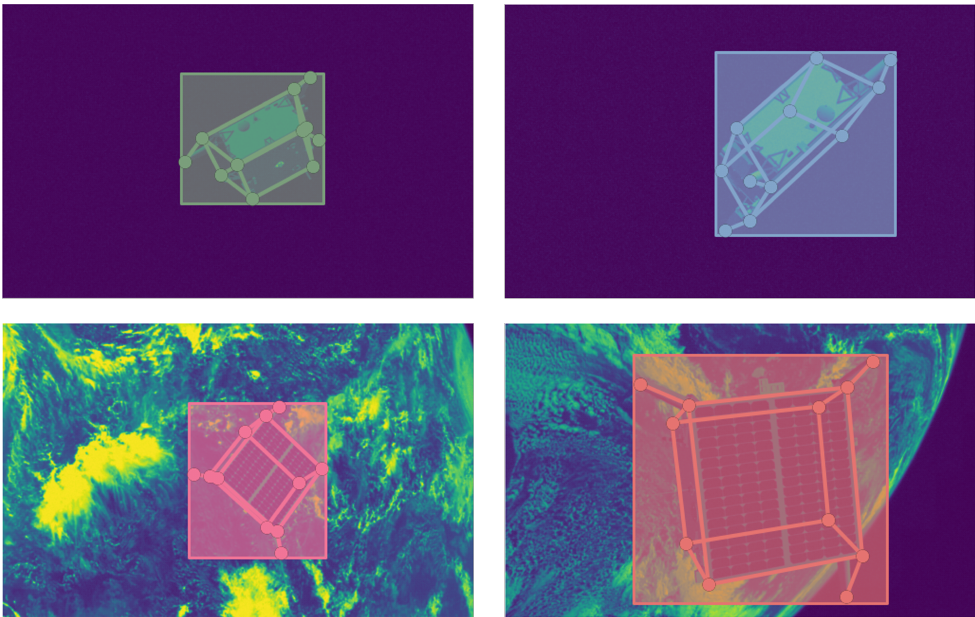
Figure 7. Examples of 2D landmark and bounding box